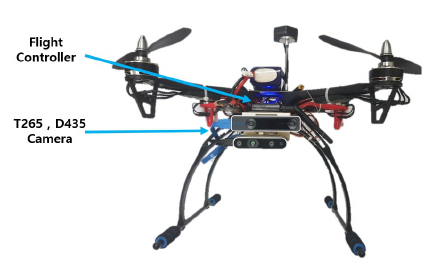
Figure 10. Quadrotor front view.